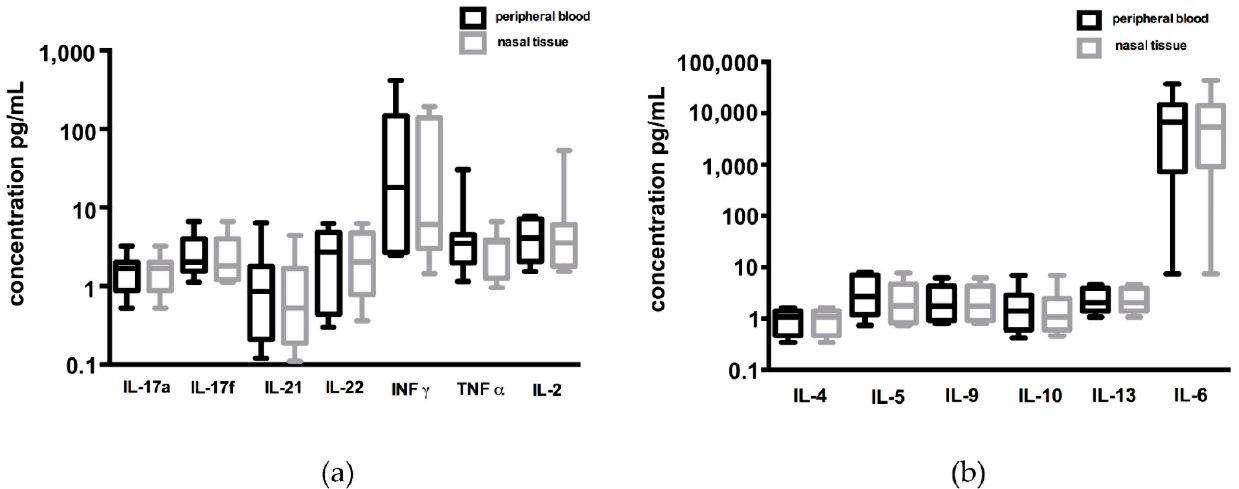
Figure 3. Comparison of cytokine secretion by CD8+ T cells from peripheral blood and inflammatory nasal tissue in CRSsNP patients: high levels of INF γ and IL-6 were found in both groups, but without any significance between both groups regarding ( a ) Th1/Th17 and ( b ) Th2 cytokines. T cells were stimulated with a peptide pool of C. albicans for 6 days, and cytokines were measured in the supernatant of the cell culture after 6 days.